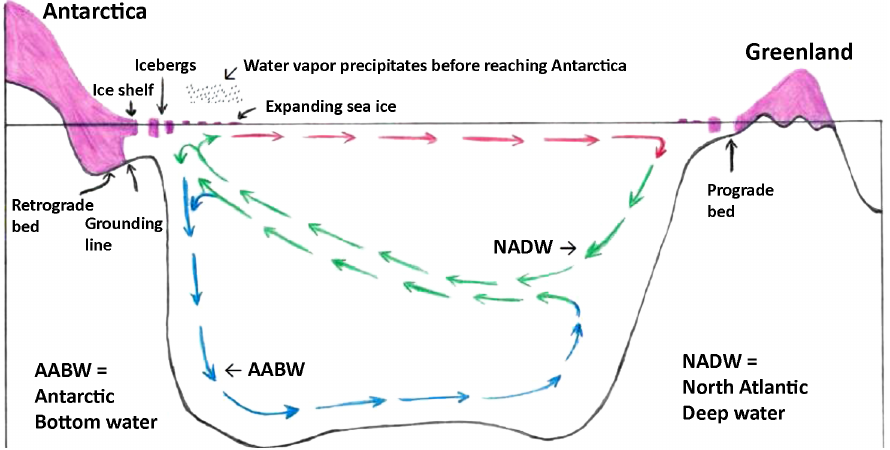
Figure 18. Schematic of stratification and precipitation amplifying feedbacks. Stratification: increased freshwater flux reduces surface water density, thus reducing AABW formation, trapping NADW heat, and increasing ice shelf melt. Precipitation: increased freshwater flux cools ocean mixed layer, increases sea ice area, causing precipitation to fall before it reaches Antarctica, reducing ice sheet growth and increasing ocean surface freshening. Ice in West Antarctica and the Wilkes Basin, East Antarctica, is most vulnerable because of the instability of retrograde